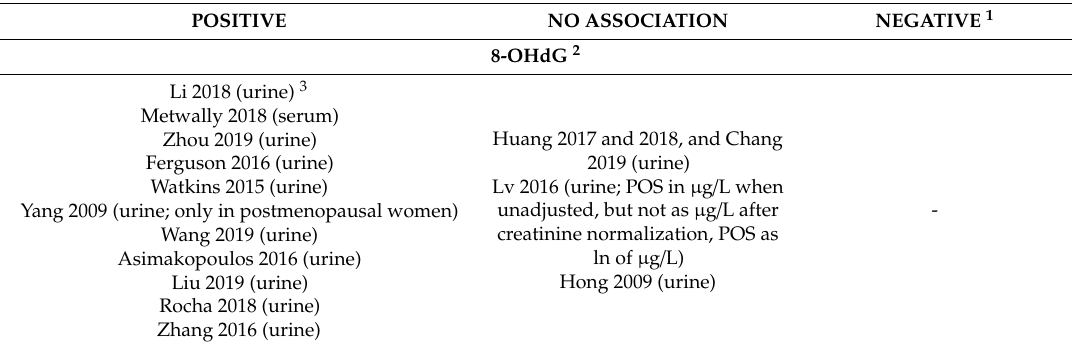
Table 2. Summary of positive, equivocal, and negative statistical associations between BPA and oxidative stress biomarkers in human